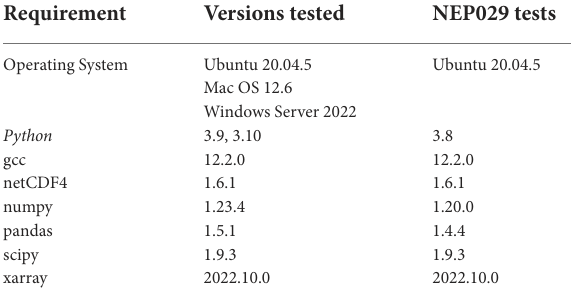
TABLE 2 Environments currently tested for sami2py